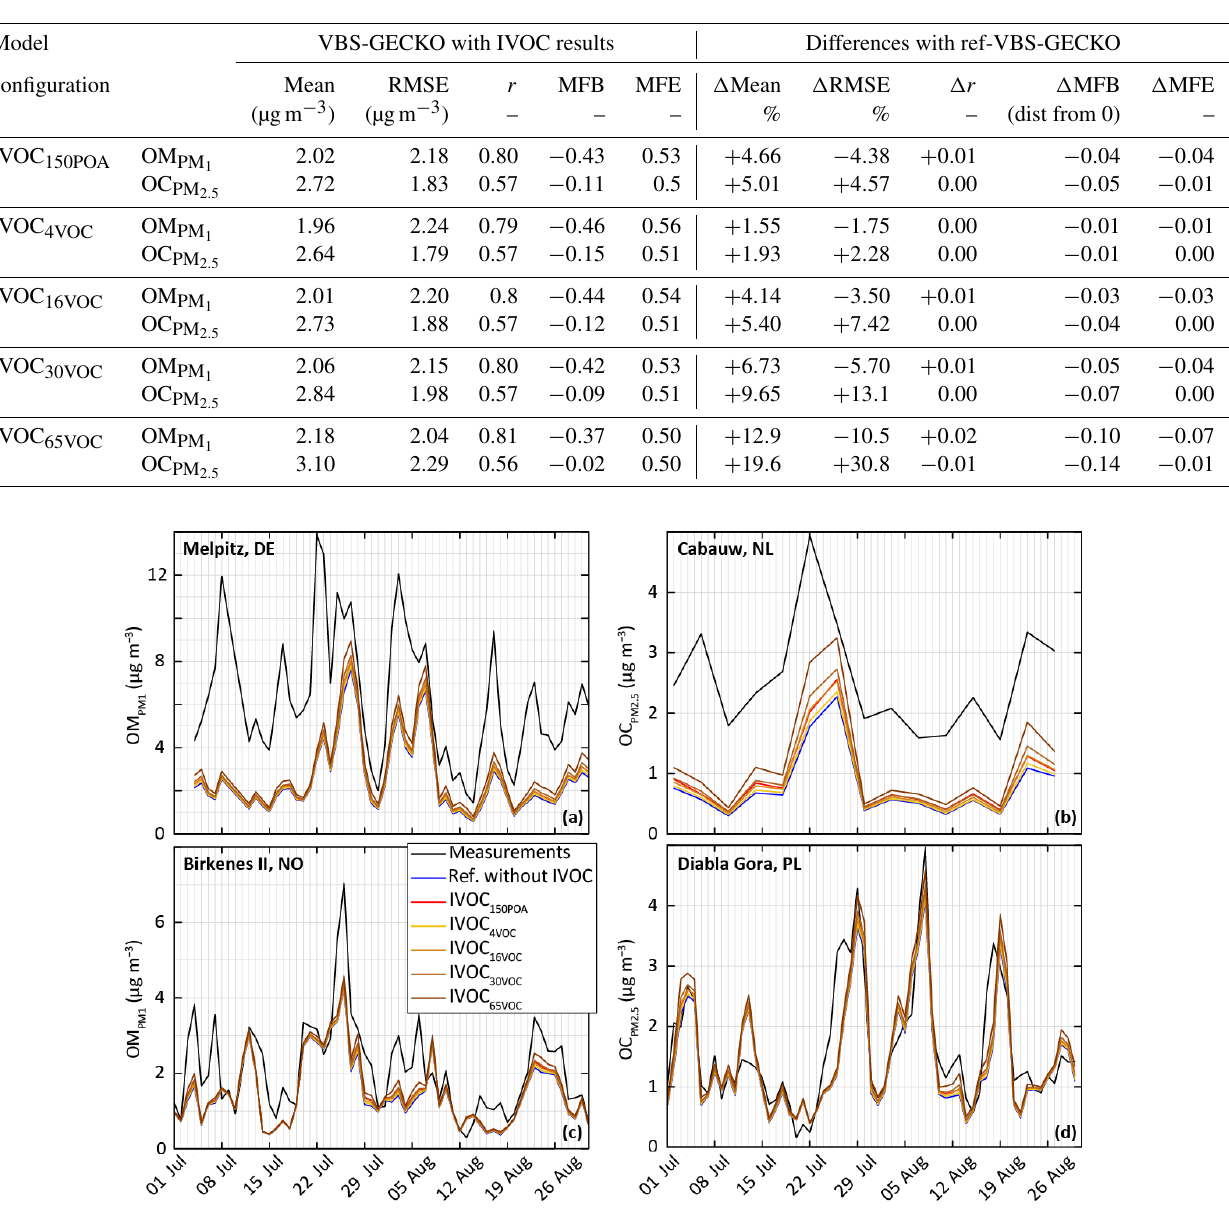
Figure 13. Measured and simulated (for the ref-VBS-GECKO configuration without IVOC and the different model configuration considering concentrations (a, c) and OC PM concentrations (b, d) . Top panels are for IVOC emissions) temporal evolution of daily averaged OM PM 1 2 . 5 stations close to anthropogenic sources in Germany (Melpitz station, a ) and the Netherlands (Cabauw station, b ) and bottom panels for stations in remote areas in Norway (Birkenes II station, c ) and Poland (Diabla Gora station, d